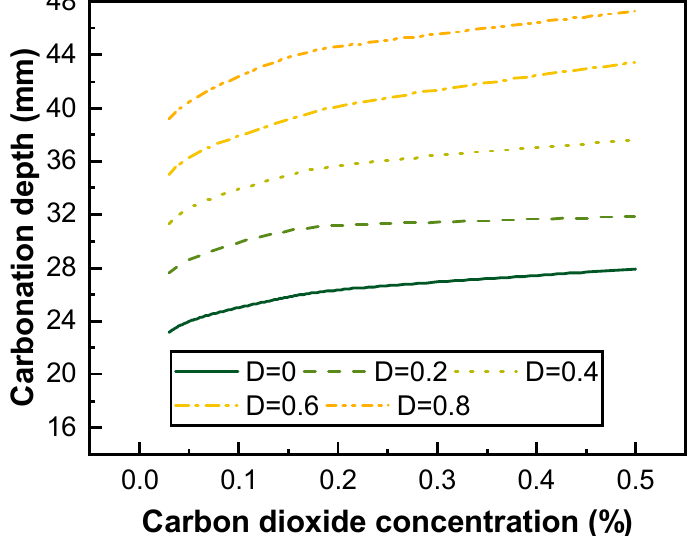
ff ect of carbon dioxide concentration on the carbonation of fatigue-damaged RC Figure 19. Effect of carbon dioxide concentration on the carbonation of fatigue-damaged RC beams. Figure 19. E